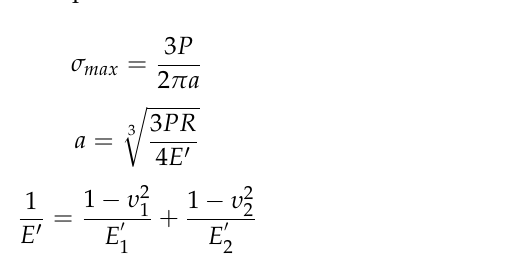
Figure 9. Columnar stacking diagram (at.%) of HEA and after wear.